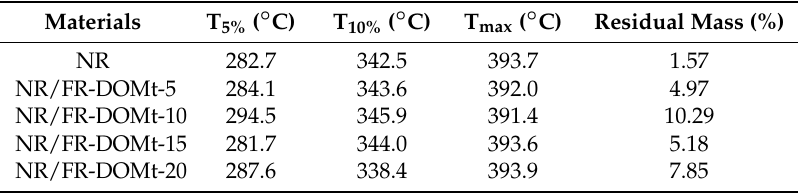
Table 3. TGA data of different NR